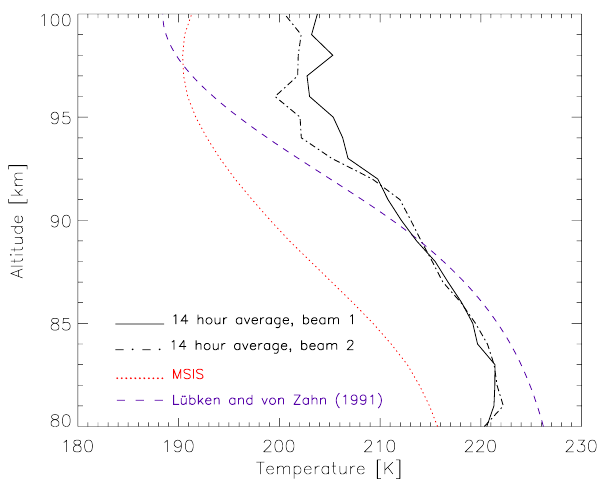
Fig. 13. The average temperature profiles based on 14h of measure- ment in beam 1 (black solid line) and beam 2 (black dashed-dotted line) with the ALOMAR Weber Na lidar on 21–22 January 2005. The red dotted line shows the temperature predicted by the MSIS model. The blue dashed line shows the temperature climatology found by L¨ubken and von Zahn (1991) based on falling spheres above